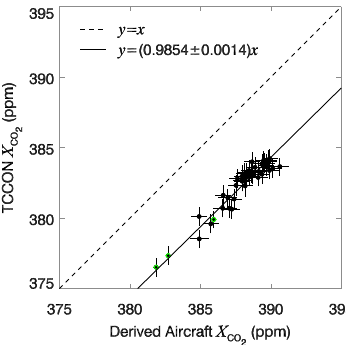
Fig. 6. Comparison of X CO from TCCON profile retrievals to that 2 derived from aircraft. Black dots indicate comparison of TCCON estimates to aircraft that measure up to 6km. Green dots are com- parison of TCCON estimates to the three aircraft profiles that mea- sure up to